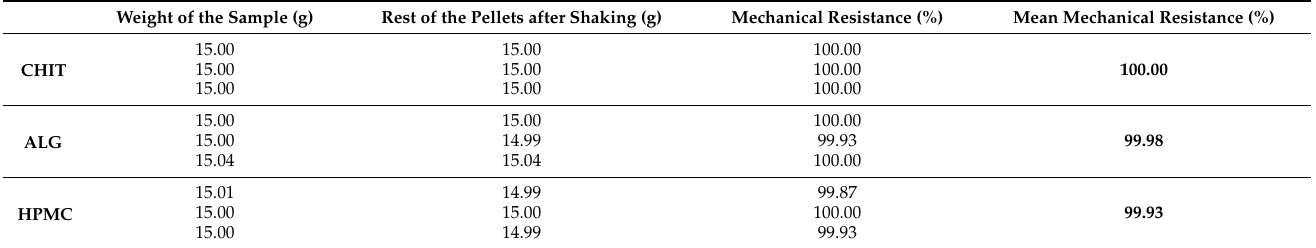
Table 4. Mechanical resistance of the pellets containing chitosan (CHIT), sodium alginate (ALG), or hydroxypropyl methylcellulose (HPMC) as a